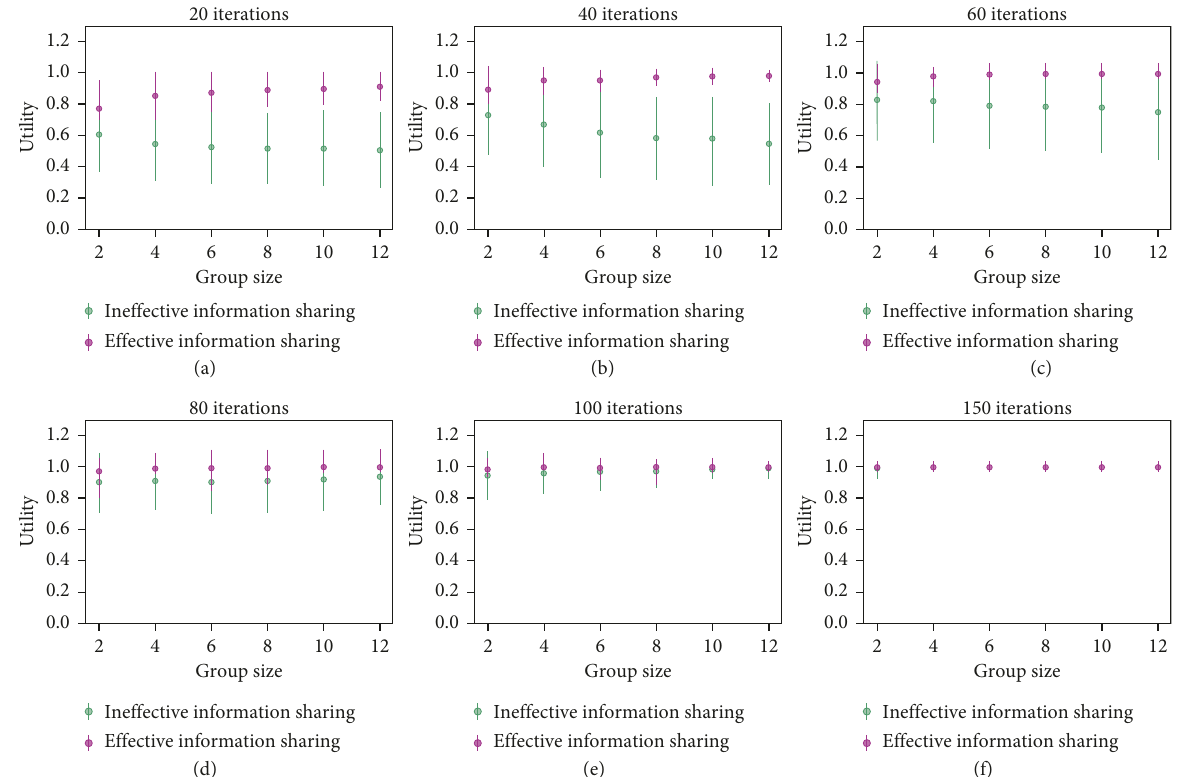
Figure 8: Bar plots regarding the effects of information sharing on group performance for the 1-peak problem space. Each dot represents the mean value, while each vertical line indicates the corresponding variance. (a) Group performance vs. group size for ineffective and effective sharing after 20 iterations. (b) Group performance vs. group size for ineffective and effective sharing after 40 iterations. (c) Group performance vs. group size for ineffective and effective sharing after 60 iterations. (d) Group performance vs. group size for ineffective and effective sharing after 80 iterations. (e) Group performance vs. group size for ineffective and effective sharing after 100 iterations. (f) Group performance vs. group size for ineffective and effective sharing after 150